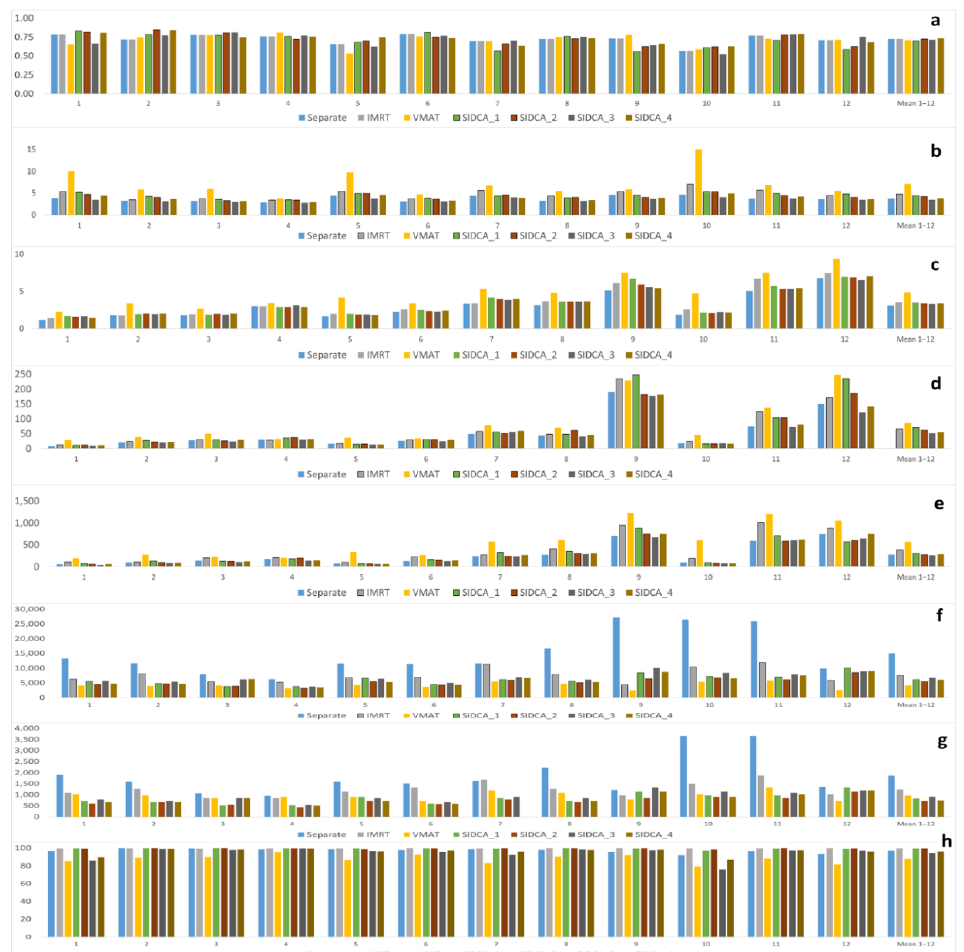
Figure 2. Comparison of the crucial parameters for different patients and planning techniques. Diagrams of the CI ( a ), the GI ( b ), the mean dose ( c ), the total V 12Gy ( d ) and V 5Gy ( e ) of the uninvolved brain, the number of MUs ( f ), irradiation time ( g ), and pass rate (3%/3 mm) ( h ) for separate-isocenter DCA (separate), IMRT, VMAT, MBM Elements v.1.6 with three couch angles (SIDCA_1), MBM Elements v.1.6 with five couch angles (SIDCA_2), MBM Elements v.2.0 with high NT (SIDCA_3), and low NT (SIDCA_4) plans for 12 patients and the mean values over these